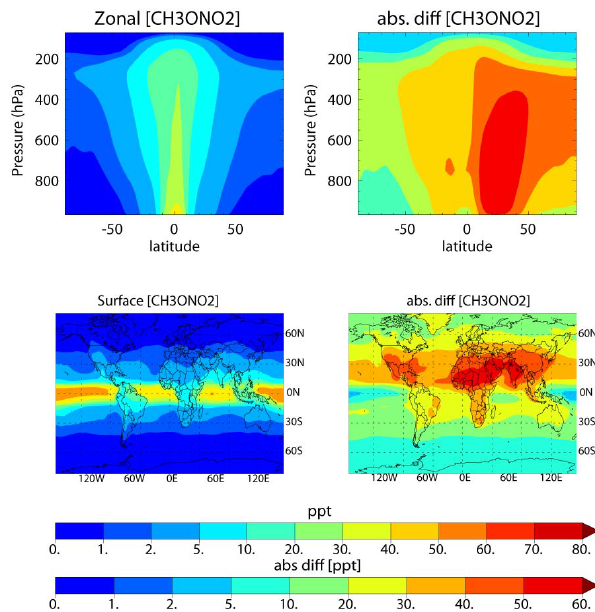
Fig. 1. The annual mean distribution in CH 3 ONO 2 during 2008. Both the zonal and horizontal means are shown (top and bottom, respectively) for EMISS. The right panels show the absolute differ- ences for FULL-EMISS given in